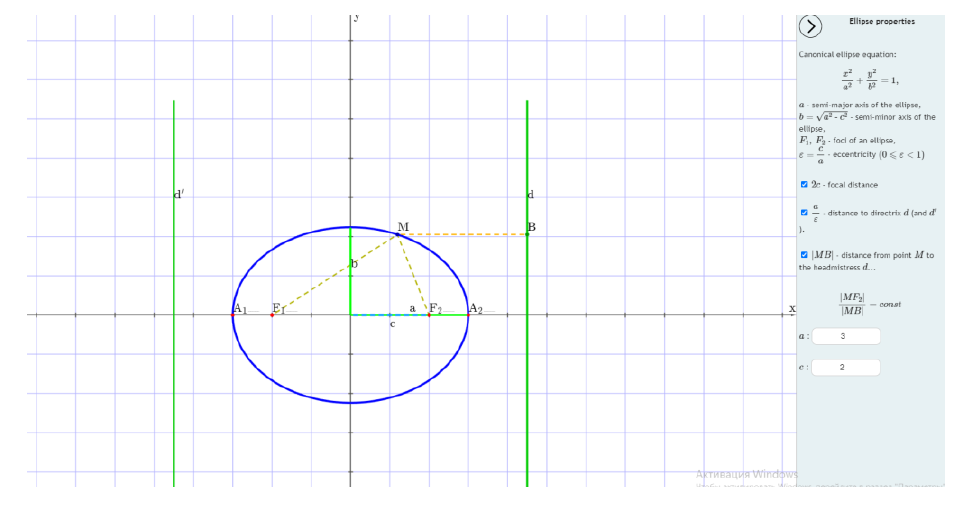
Fig. 1. 2D rendering of an ellipse.